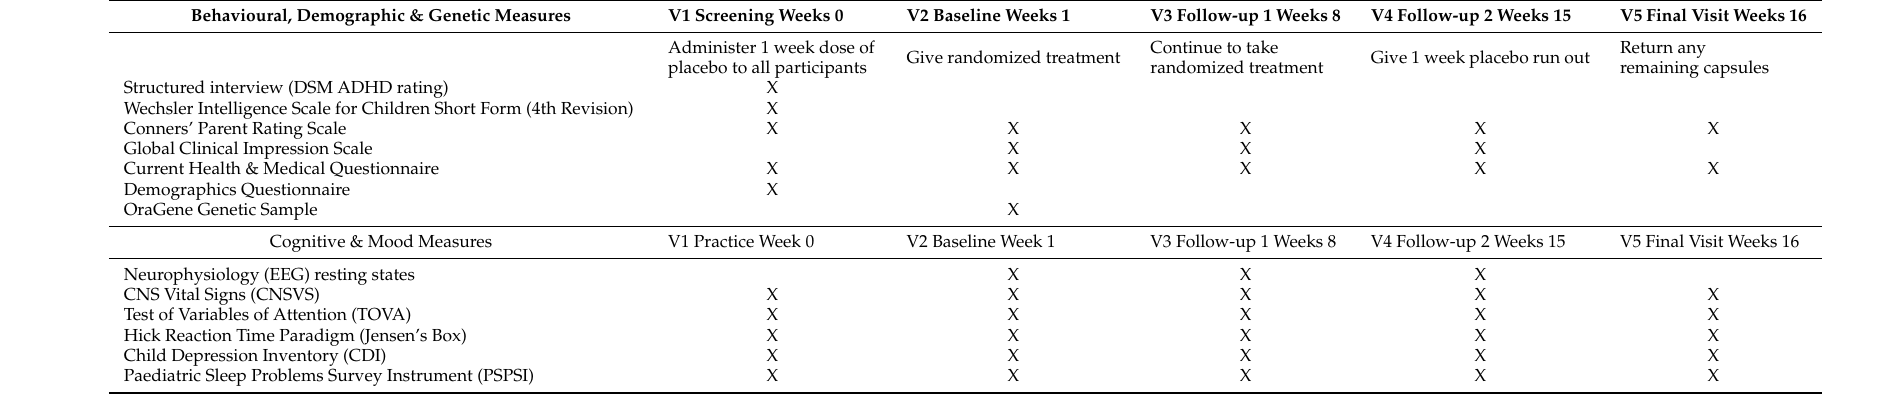
Table 1. Measures and Visit